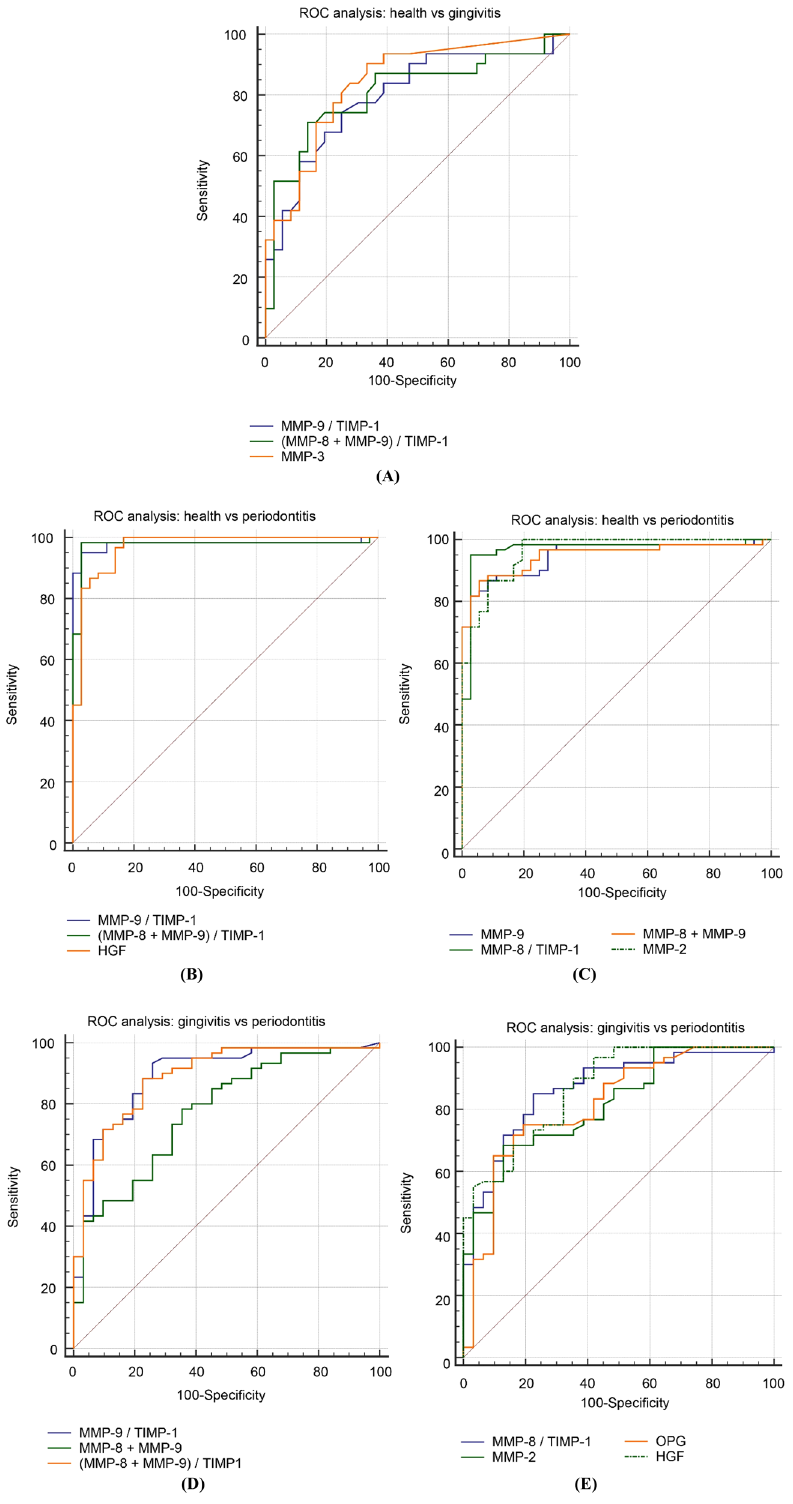
Figure 2. Classification and diagnostic accuracy mode for distinguishing different stages of periodontal disease. ROC (receiver-operating characteristic analysis) and AUC (the area under ROC curve) as described ealrier 3 . ( A ) health versus gingivitis (AUC ≥ 0.80); ( B , C ) health versus periodontitis (AUC ≥ 0.95); and ( D , E ) gingivitis versus periodontitis (AUC ≥ 0.85). ( B , C and D , E were split in two graphs due to graphical software